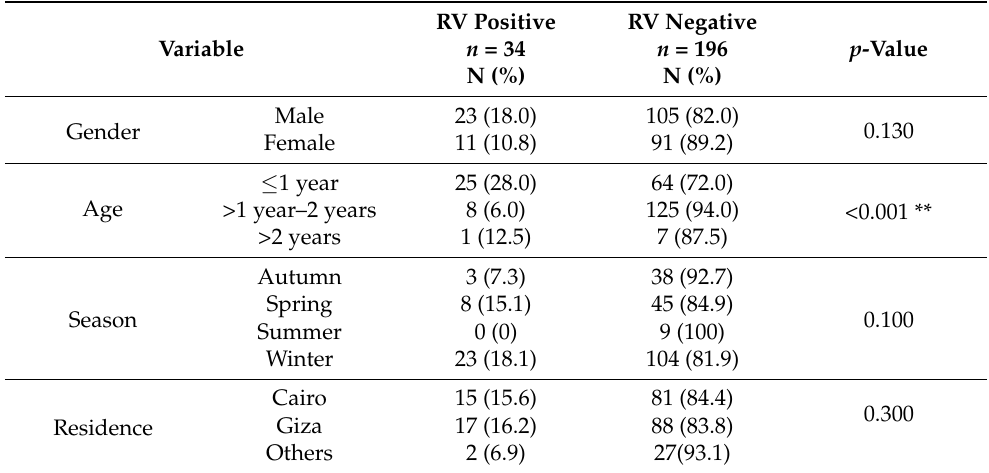
Table 1. Distribution of positive rotavirus (RV) samples in relation to gender, age, season, and